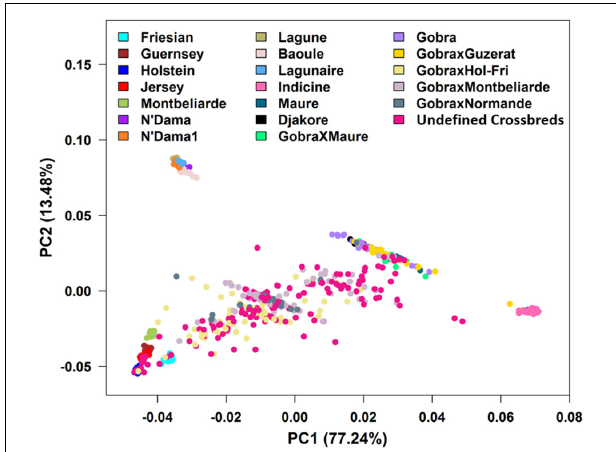
FIGURE 3 | Plots of PC1 vs. PC2 for Bos indicus , African and European Bos taurus , West African indigenous and crossbred populations.